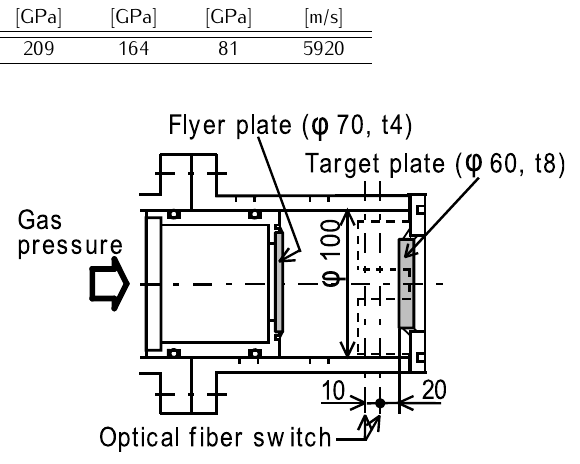
Figure 1. Location of the target, flyer and the ‘velocity measurement unit’ denoted in the schematic of the experimental setup. The exact dimensions used in our experiments are indi- cated in the